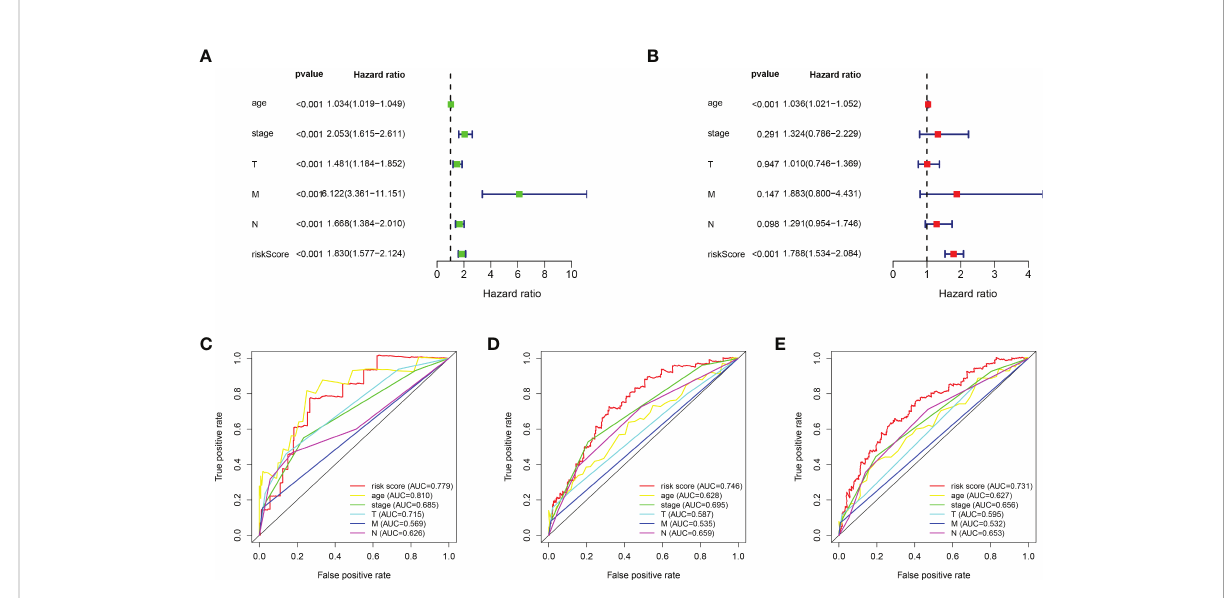
FIGURE 5 Evaluation of the predictive power of the ARlncRNA model. (A, B) Univariate (A) and multivariate (B) Cox regression analyses indicating that age and risk score could be independent prognostic factors for BRCA. (C – E) The 1- (C) , 3- (D) , and 5-year (E) AUC of the ARlncRNA model values were >0.7. The 3- and 5-year AUCs had the maximum values.